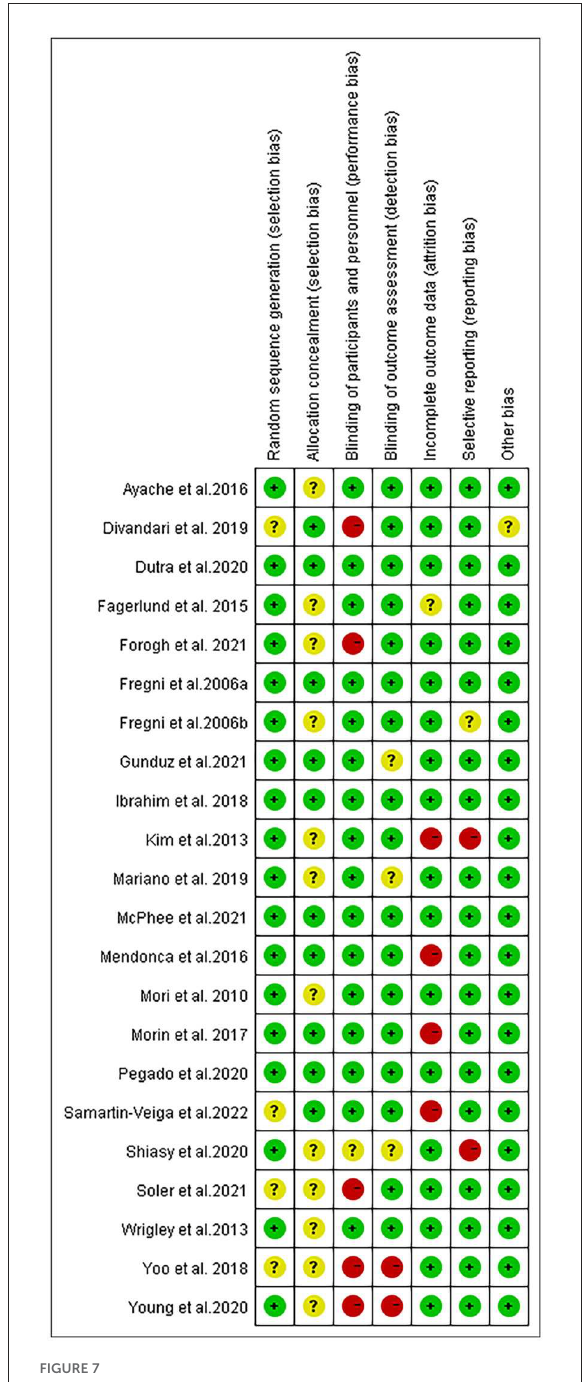
FIGURE7 Methodological quality summary: review authors’ judgements about each methodological quality item for each included